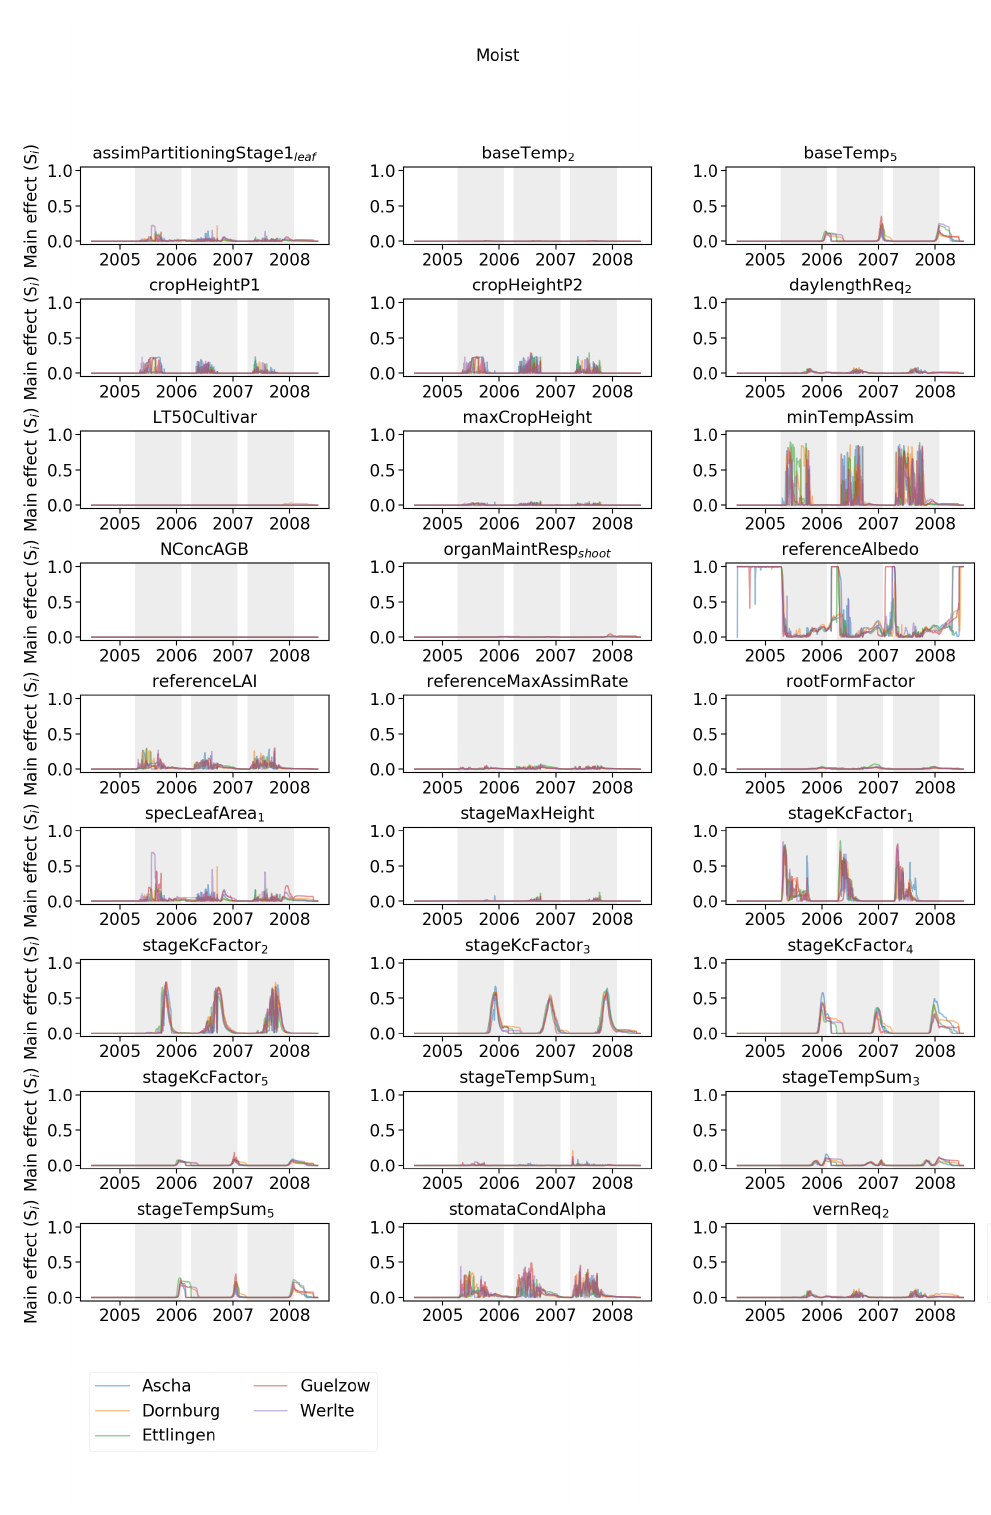
Figure A5. Daily S i values calculated using the extended FAST method for Moist differentiated among the different